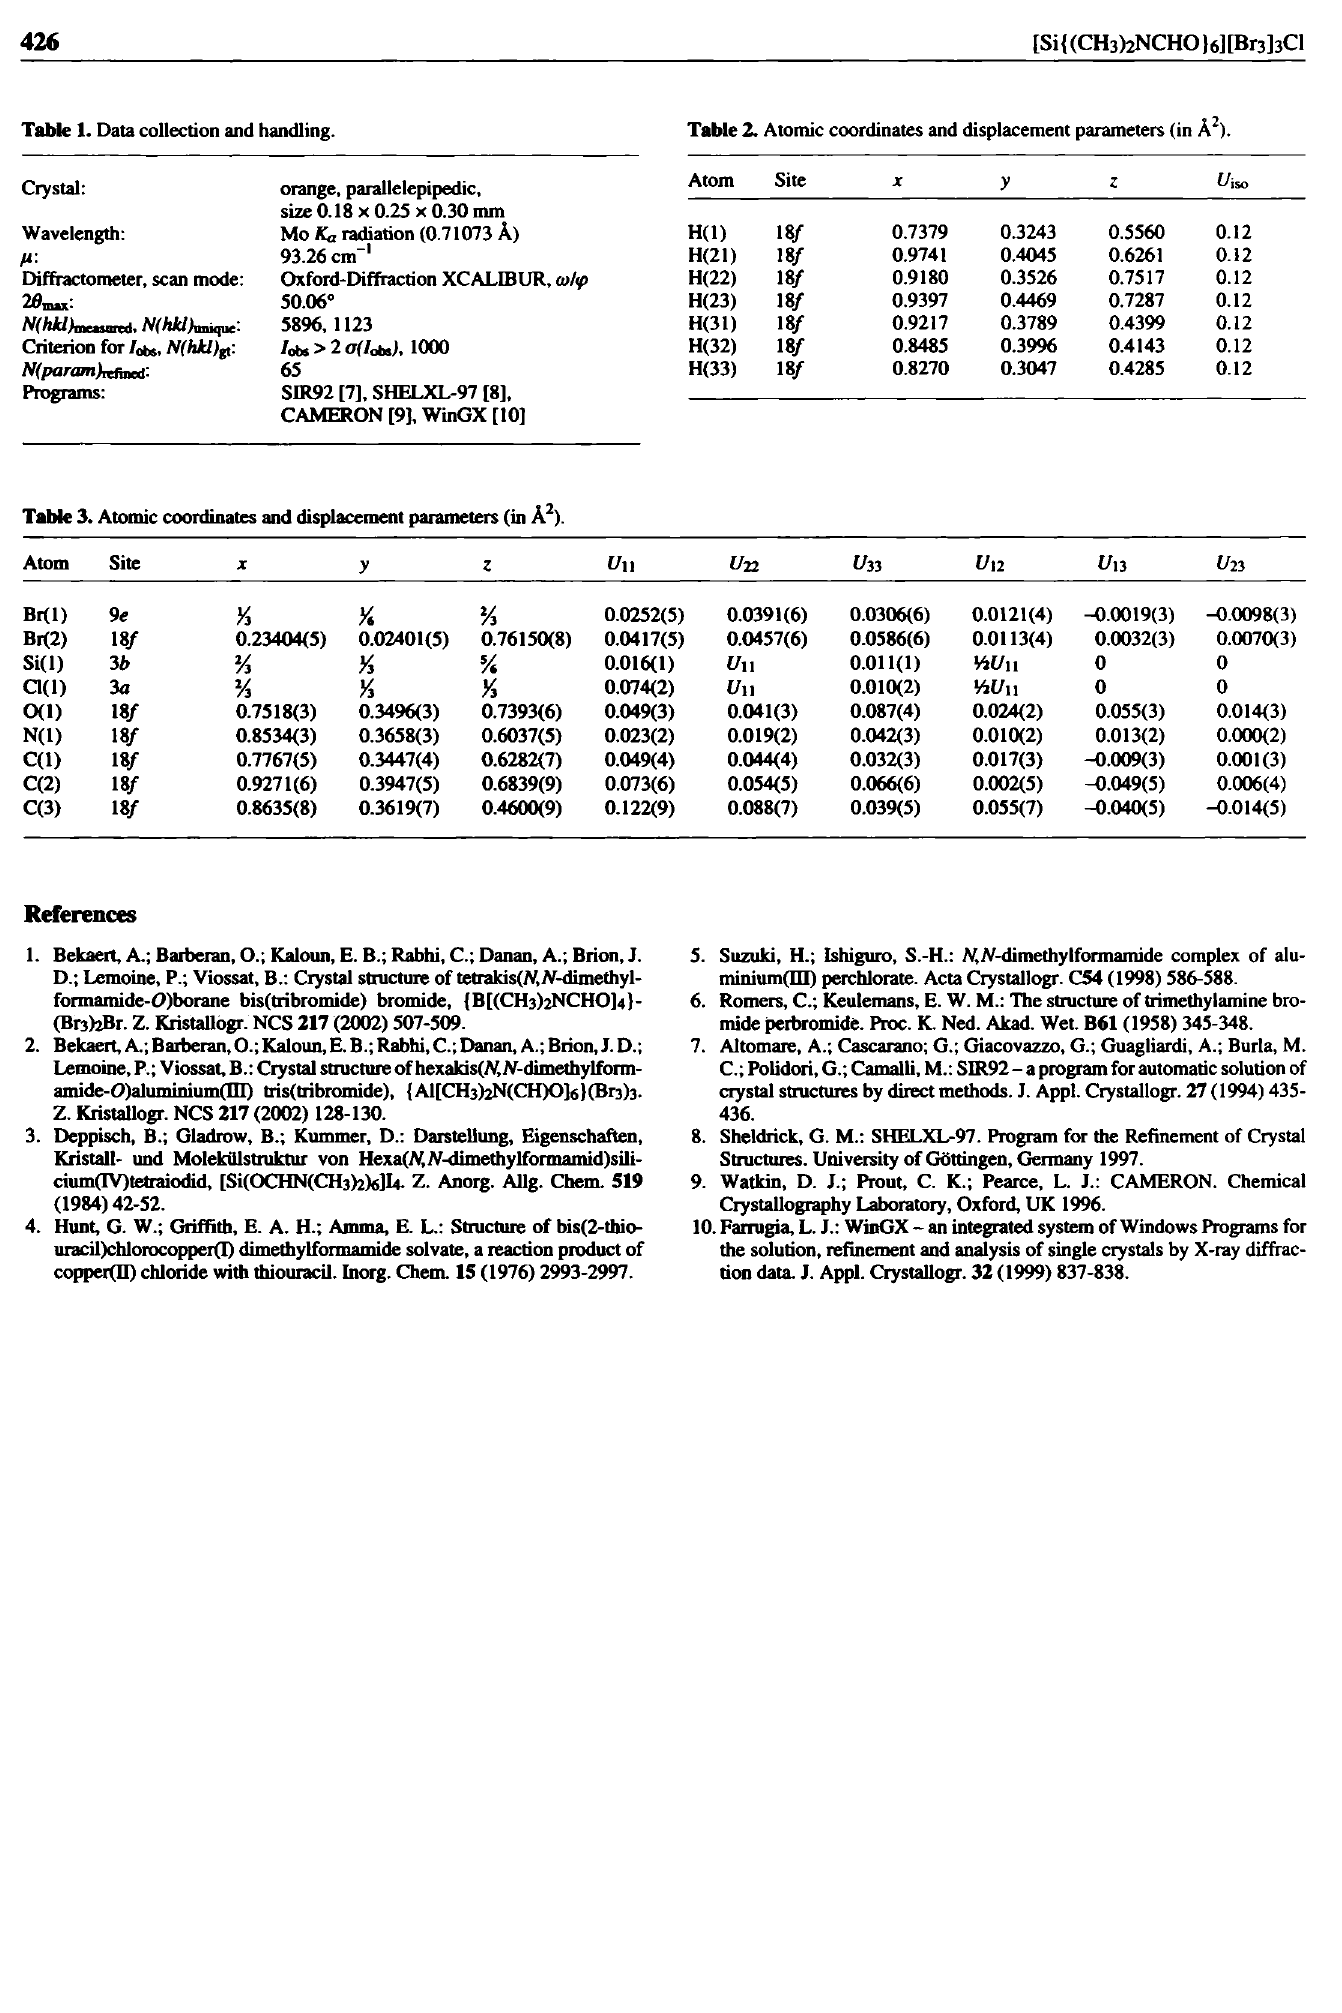
Table 1. Data collection and handling. Table 2. Atomic coordinates and displacement parameters (in A 2 ).